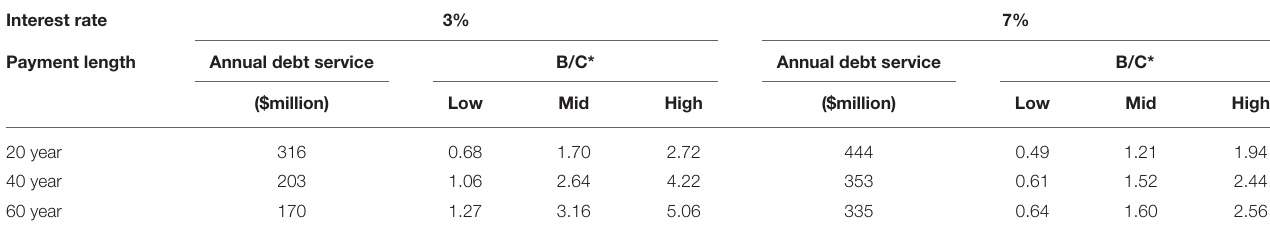
TABLE 7 | Cost of Boston Harbor Cleanup vs. benefit of ecosystem